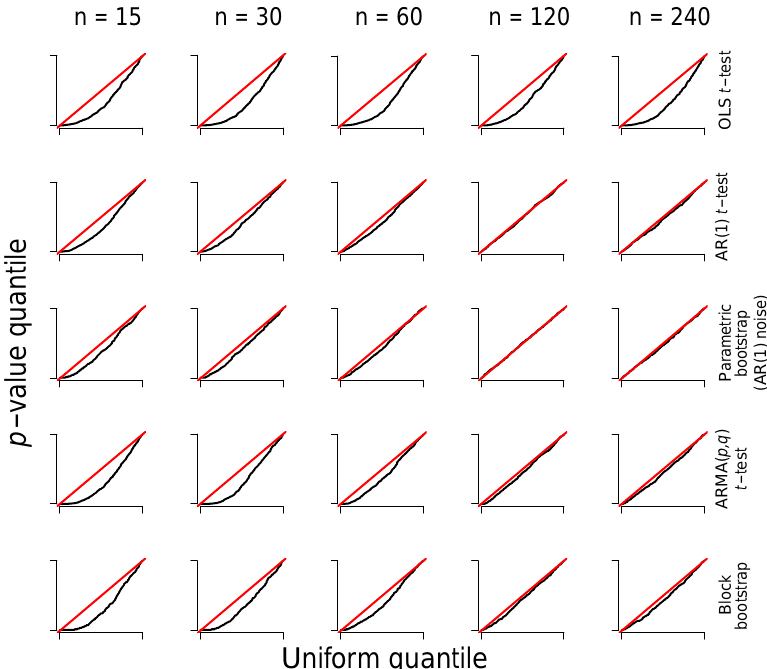
Figure 7. Quantile–quantile plots comparing the distribution of nominal p values to the theoretical uniform distribution. Simulations are of mean zero, Gaussian AR(1) time series and p values correspond to a two-sided test for a linear time trend. The length of the time series is given above each column. In the first row, the p values are from the OLS t test assuming independent noise; the second row is the t test assuming AR(1) noise; the third row uses a parametric bootstrap (again assuming AR(1) noise); the fourth row uses a t test assuming ARMA( p,q ) noise with the order of the model selected by AICc; and the last row uses a circular block bootstrap with block size chosen to be favorable to this method. The p values calculated assuming the correct parametric model appear approximately correct for modest sample sizes and always outperform both blind selection by AICc and the block bootstrap. The latter two methods can be worse than assuming independence when sample sizes are very small.